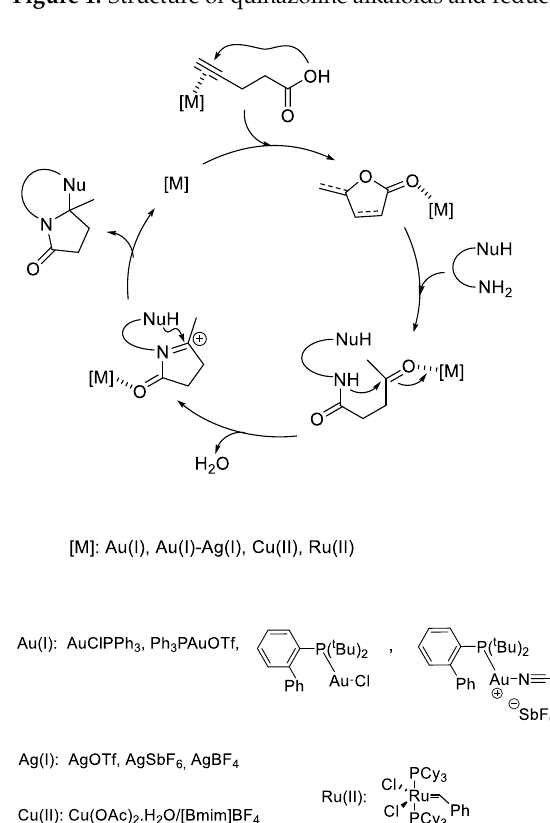
Figure 1. Structure of quinazoline alkaloids and reductase inhibitor pyrrolobenzimidazolone.